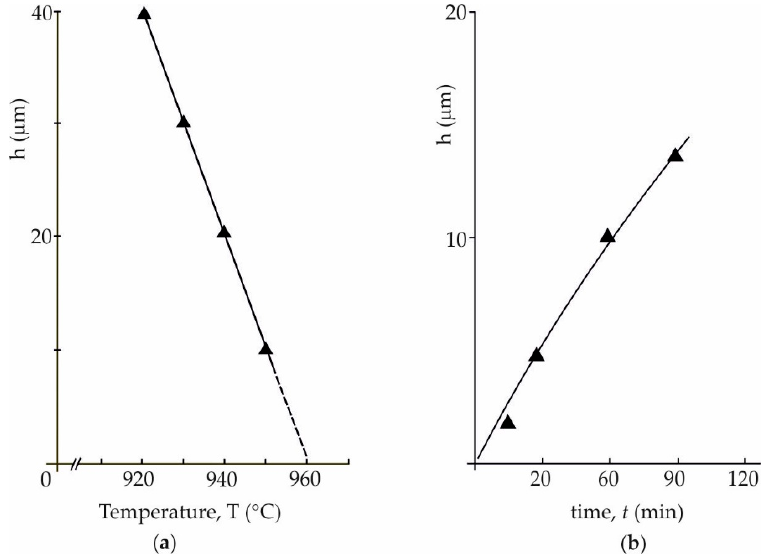
Figure 2. The thickness of the NdGa 2.97 Cr 0.03 (BO 3 ) 4 epilayer: ( a ) vs. growth temperature ( t = 60 min, ν = 27.3 min − 1 ); ( b ) vs. growth time ( T = 950 ° C, ν = 27.3 min − 1 ) [31]. Reprinted from the Journal of Crystal